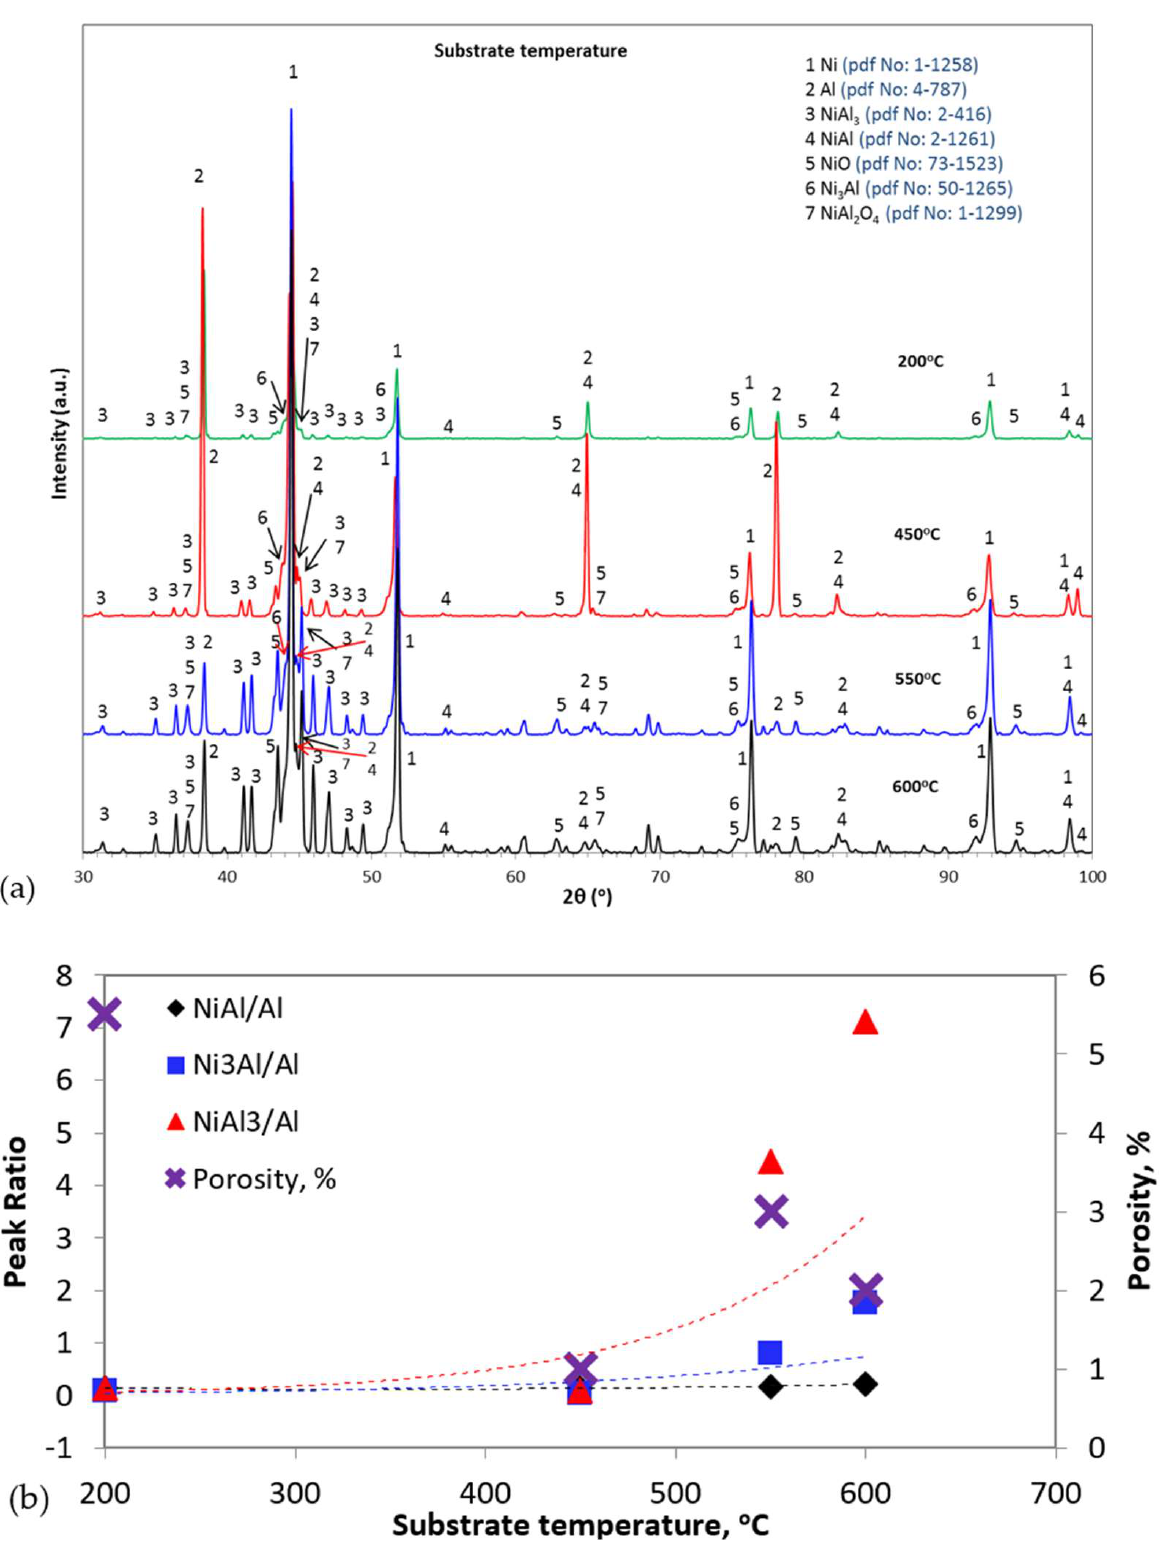
Figure 6. ( a ) XRD pattern of the surfaces formed with different substrate temperatures and ( b ) coating porosity and semiquantitative analysis of the intermetallic phases present in the coating as functions of the substrate temperature.